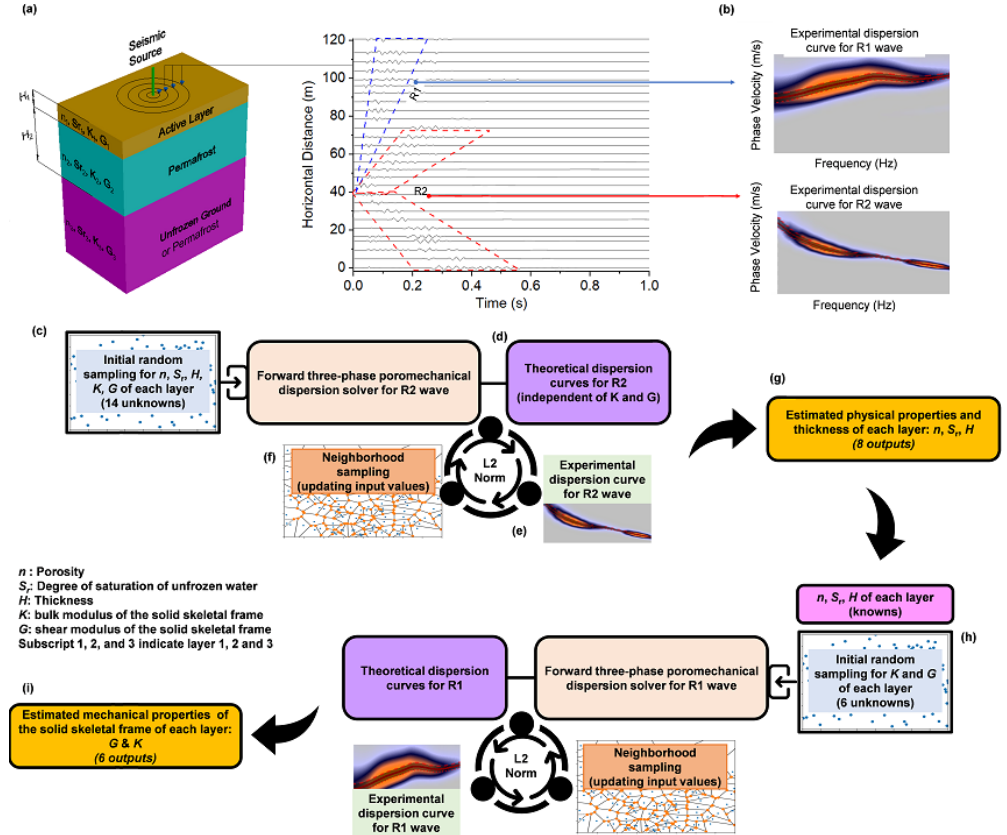
Figure 1. (a) A general schematic of the MASW test at a permafrost site. (b) Dispersion image of R1 and R2 waves obtained from the experimental measurements. (c) Initial guess of the physical properties of active layer, permafrost layer, and unfrozen ground. (d) Calculation of the theoretical dispersion relation of the R2 wave using the forward three-phase poromechanical dispersion solver. (e) Solution ranking based on L 2 norm for R2 dispersion relations (experimental versus theoretical) using the hybrid inverse and poromechanical approach. (f) Neighborhood sampling for the reduction in L 2 norm using the hybrid inverse and poromechanical approach. (g) Select the best samples based on the minimum L 2 norm and obtain the physical properties and thickness for each layer. (h) Repeat the steps for dispersion inversion (c–f) of R1 dispersion relation to derive the mechanical properties of active layer, permafrost layer, and unfrozen ground. (i) Select the best samples based on the minimum L 2 norm and obtain the mechanical